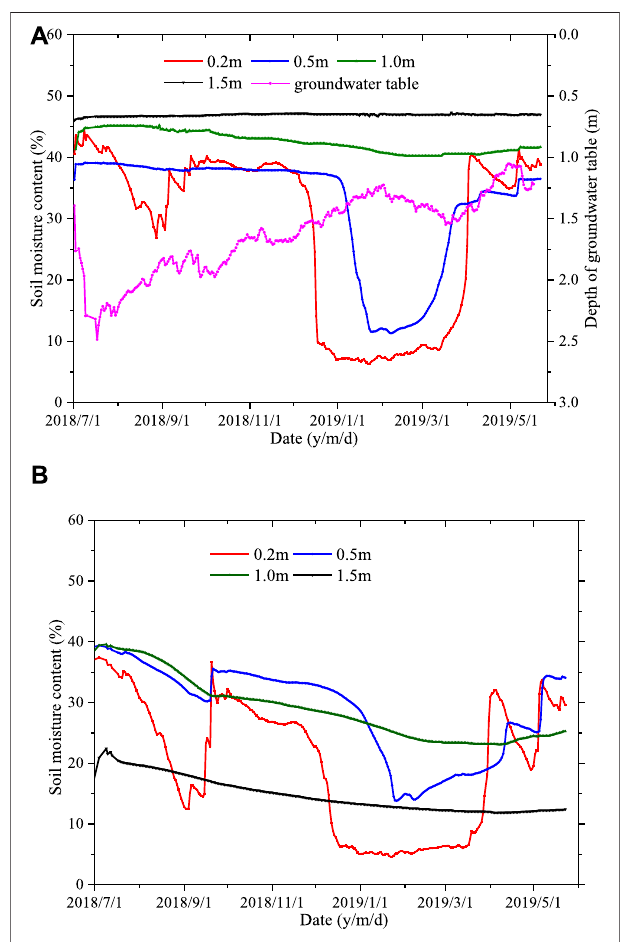
FIGURE 5 | Depth of groundwater table and soil moisture content at various depths. (A) Data from the Qiujilangwa village monitoring site; (B) data from the Duoma village monitoring